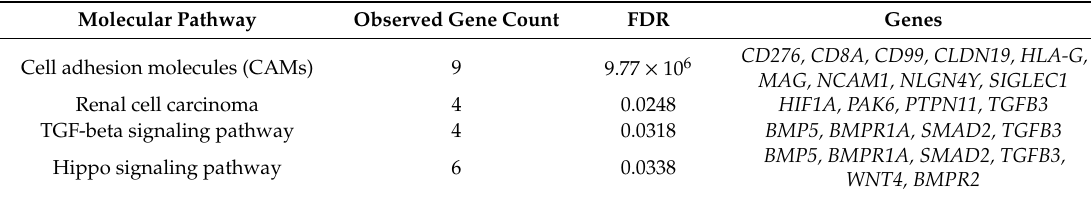
Table 4. Kyotto Encyclopedia of Genes and Genomes (KEGG) enrichment pathway to target genes of